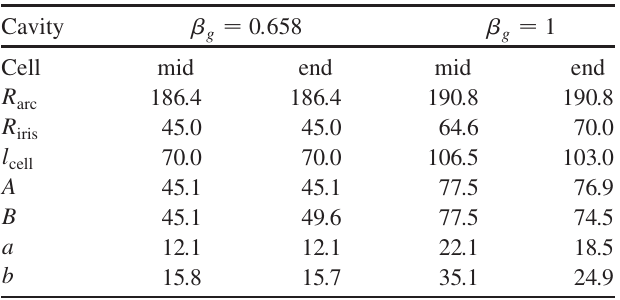
TABLE XI. Shape parameters of the medium and high beta cavities. Both are symmetric five cell elliptical SC cavities. All values are given in mm.